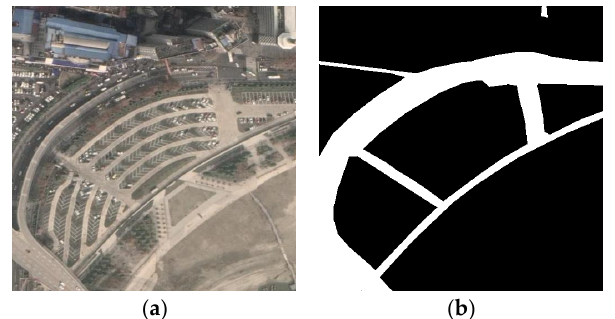
Figure 3. Test set images of dataset III: ( a ) true-color, ( b ) ground-truth maps.